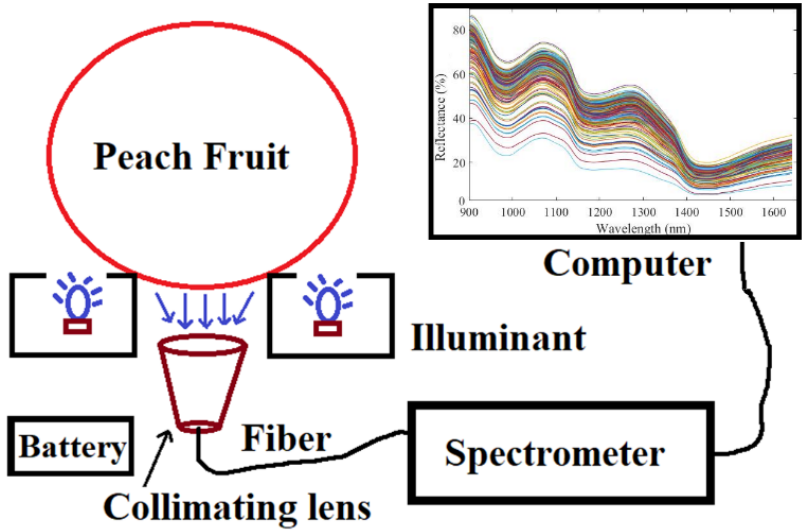
Figure 1. Schematic diagram of peach spectrum acquisition.